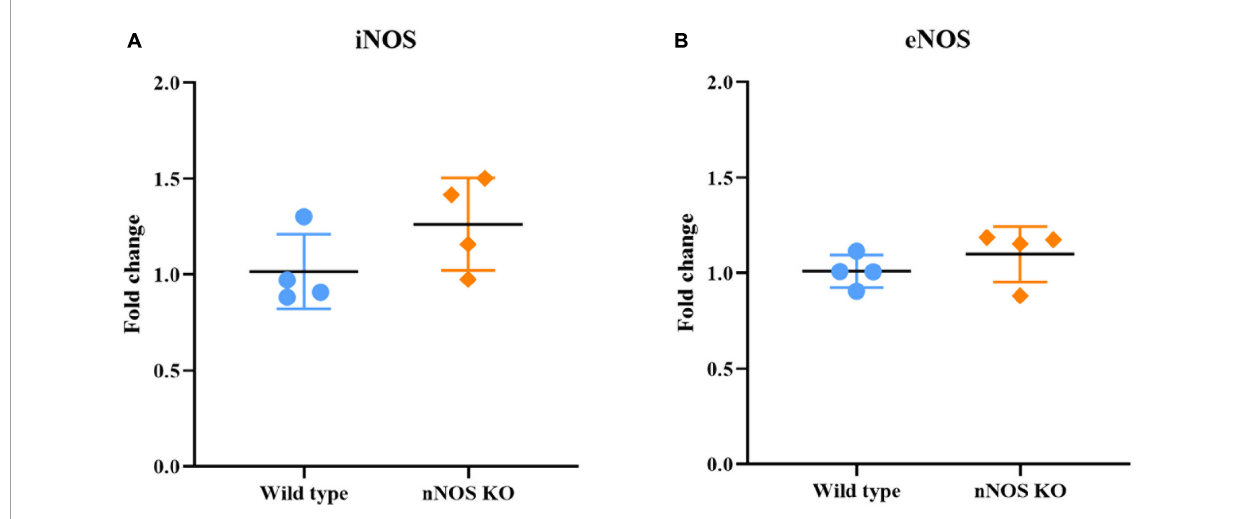
FIGURE3 Genetic analyses of iNOS and eNOS. Charts summarizing statistical analyses of the iNOS (A) and eNOS gene expression (B) in the MOB of wild-type and nNOS-KO mice. The mRNA expression of genes corresponding to the iNOS and eNOS isoforms was similar for both experimental animal models, with no significant differences between the experimental groups (iNOS in wild-type mice 1.01 ± 0.19 fold change and iNOS in nNOS-KO mice 1.26 ± 0.24 fold change [ p = 0.114; (A) ]; eNOS in wild-type mice 1.01 ± 0.08 fold change and eNOS in nNOS-KO mice 1.09 ± 0.14 fold change [ p = 0.886; (B)